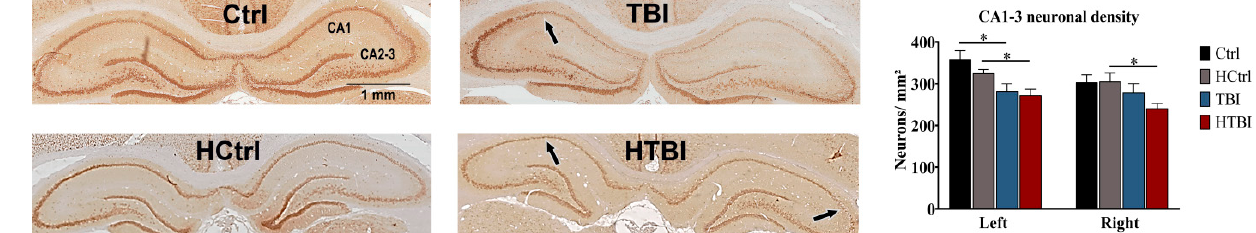
Figure 6. Assessment of neuronal densities. Shown are neuronal nuclei (NeuN) stained histological coronal hippocampal sections. Neuronal densities were calculated by dividing the number of NeuN positive cells into the CA1-3 regions over the hippocampal surface area. Analyses were conducted on 3–5 animals from each group and 6 sections were obtained from each brain. The HTBI and TBI groups had comparable left and right CA1-3 hippocampal neuronal densities ( p > 0.05), as revealed by one-way ANOVA with post hoc Fisher’s least significance difference (LSD). In the left hippocampus, both HTBI and TBI rats had a significantly lower neuronal density, compared to their respective controls, HCtrl and Ctrl ( p < 0.05, one-way ANOVA with post hoc Fisher’s LSD). In the right hippocampus, the HTBI group had significantly lower CA1-3 neuronal densities ( p < 0.05) compared to its control, the HCtrl group, but the TBI group was comparable to its control ( p > 0.05) on that side (one-way ANOVA with post hoc Fisher’s LSD). The arrows are pointing to the areas of most prominent neuronal loss and thinning in the CA1-3 regions. Analyses of the cortical areas revealed that the right and left parietal cortical neuronal densities were minimally but significantly lower in the HTBI group (604.2 ± 8.3 neurons/mm 2 , and 606.4 ± 8.1 neurons/mm 2 , respectively), compared to all other groups (642.4 ± 16.1 neurons/mm 2 on the right and 669.1 ± 14.5 neurons/mm 2 on the left for TBI; 656.4 ± 15.4 neurons/mm 2 on the right and 647.1 ± 9.3 neurons/mm 2 on the left for Ctrl; 634.3 ± 11.1 neurons/mm 2 on the right and 652.4 ± 11.9 neurons/mm 2 on the left for HCtrl, p < 0.05, one-way ANOVA). The TBI group had comparable bilateral parietal cortical neuronal densities to control rats ( p > 0.05, one-way ANOVA). Asterisks indicate statistically significant differences (p<0.05). Mean ± SEM are represented. (Ctrl: control; HCtrl: hepa-